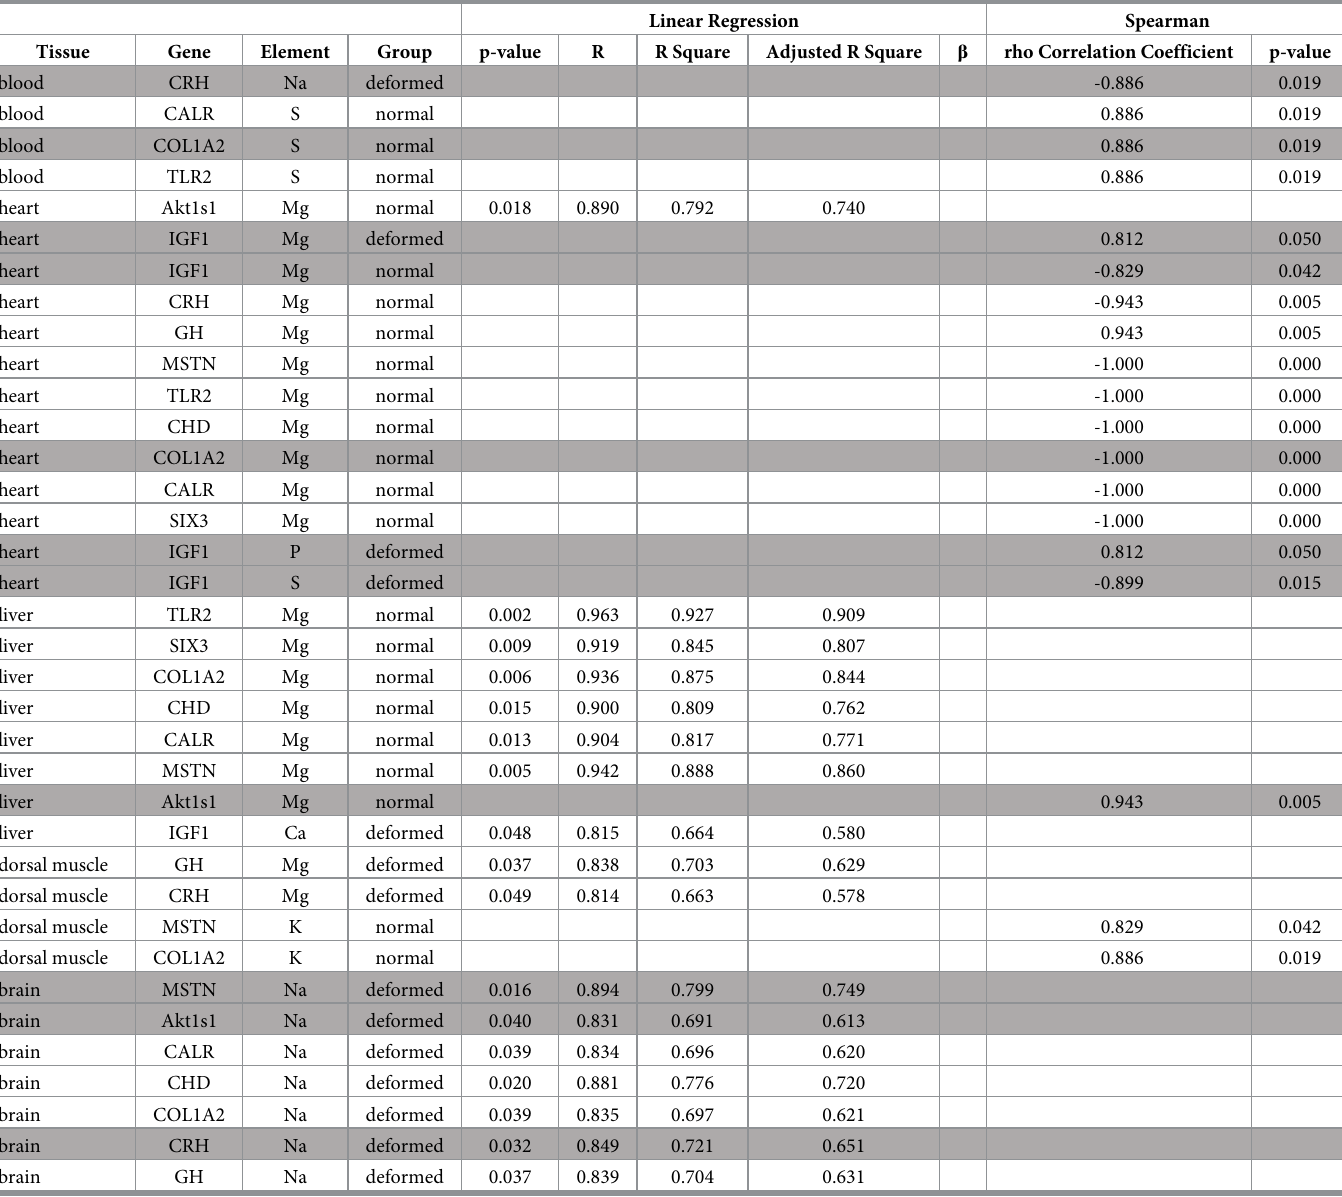
Table 3. The result of significant correlations between mRNA levels and spinal macroelement contents based on linear regression and Spearman’s correlation test. Linear Regression